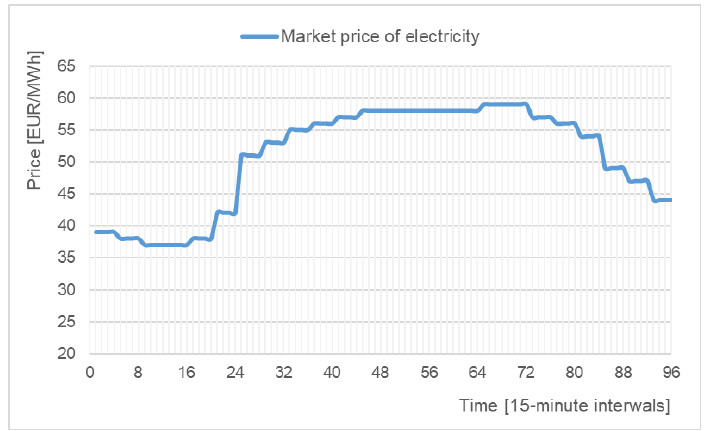
Figure 8. Market price pattern (own development based on [29]).